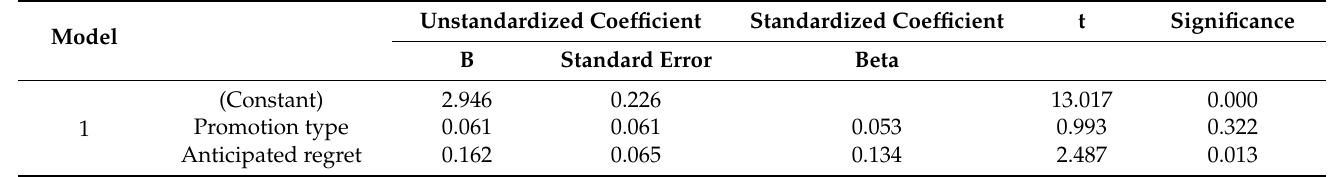
Table 16. Regression Coefficients a .